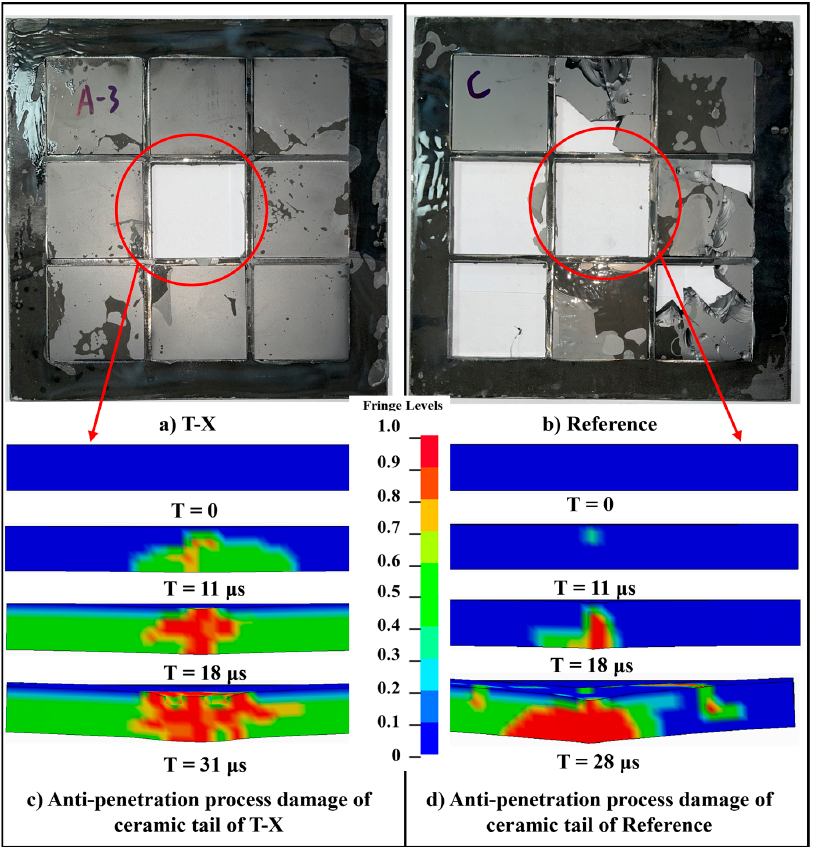
Figure 13. The anti-penetration process damage of ceramic tail of different targets. ( a ) Experiment result of ceramic tiles damage of T-X. ( b ) Experiment result of ceramic tiles damage of Reference. ( c ) Simulation result of ceramic tiles damage of T-X. ( d ) Simulation result of ceramic tiles damage of Reference.